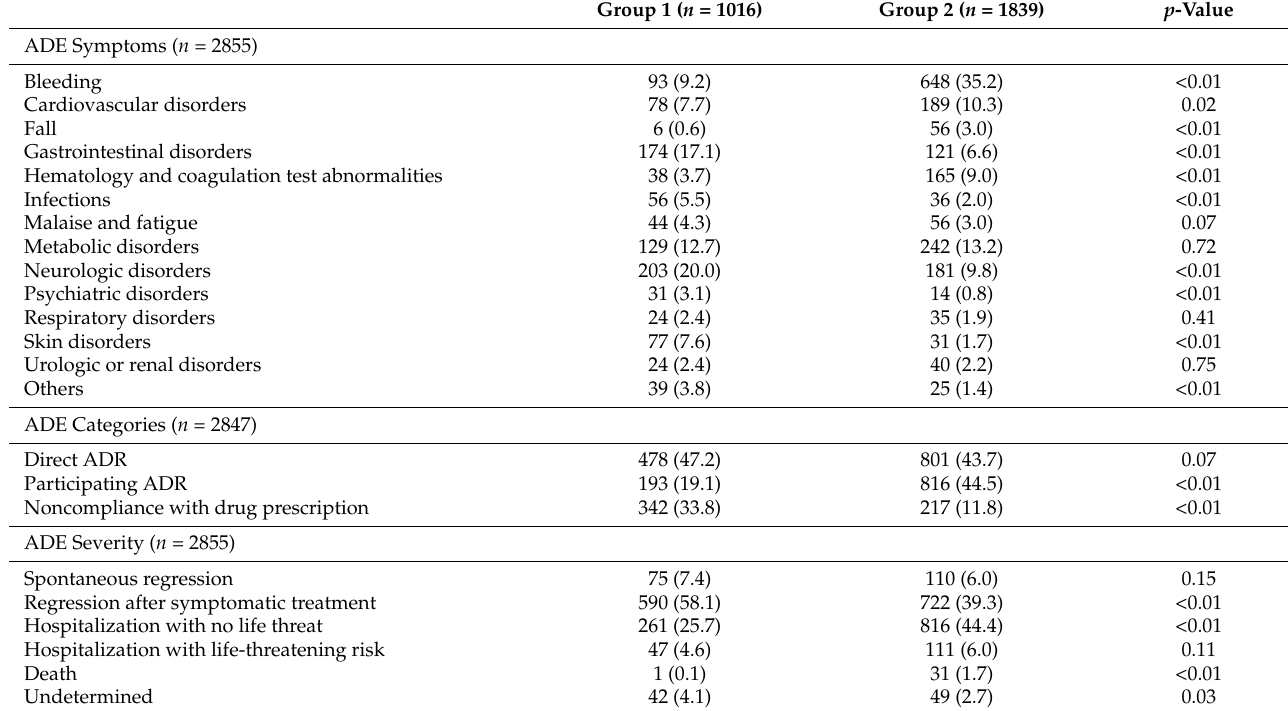
Table 3. Characteristics of ADEs by age group.